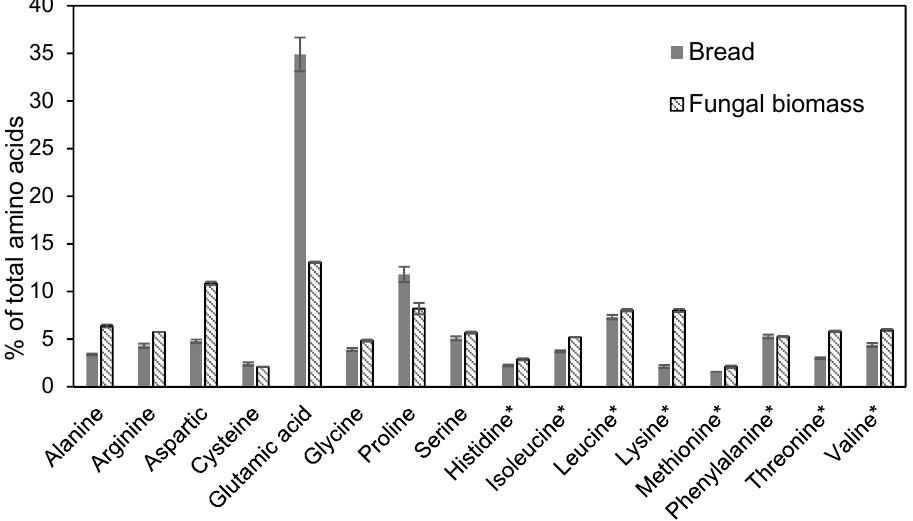
Figure 6. Contents of amino acids in the substrate (bread) and final biomass obtained through cultivation in the 26 L bioreactor. The error bars represent ± one standard deviation. Asterisks (*) indicate essential amino